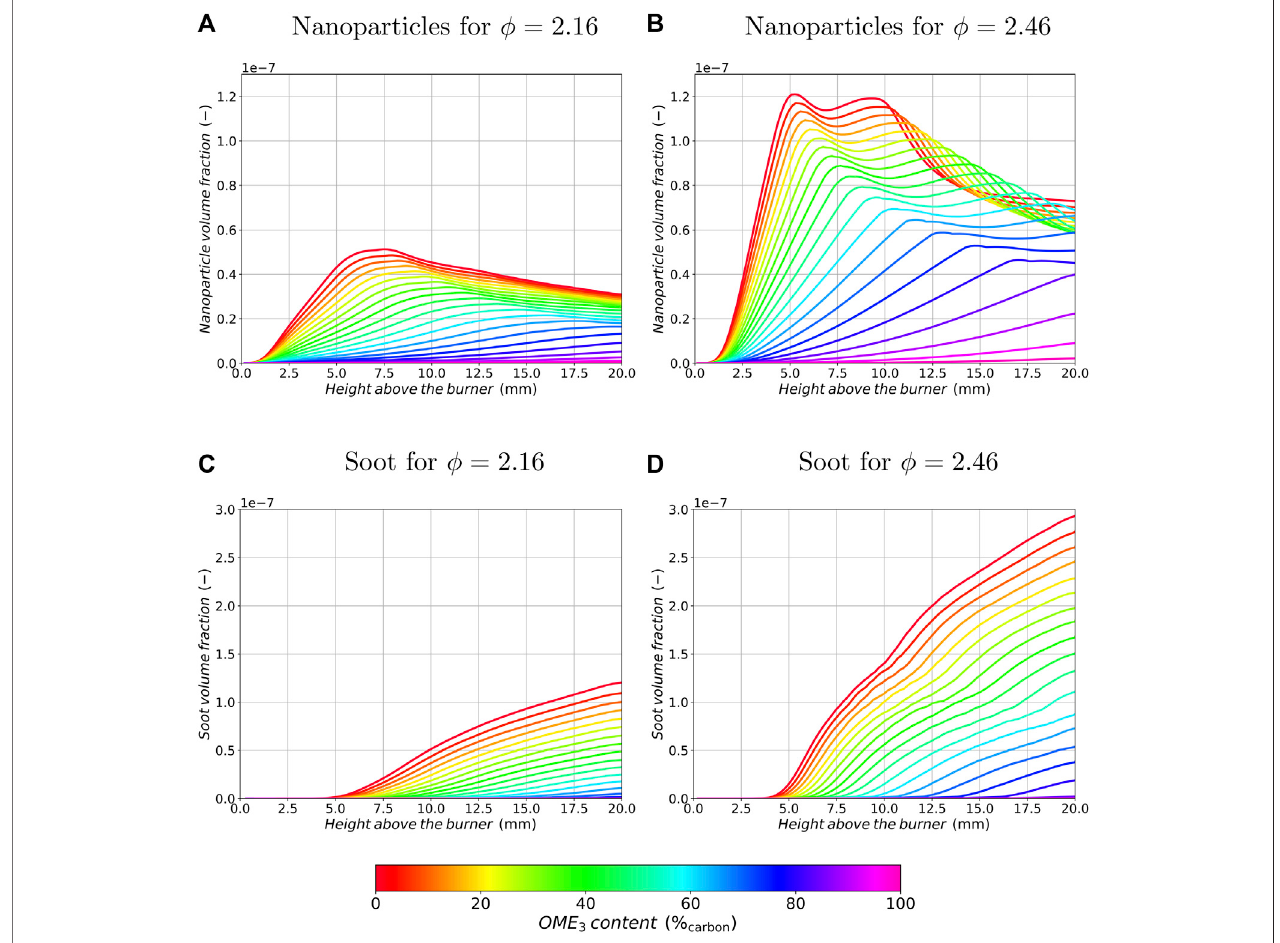
FIGURE 4 | Nanoparticle (A,B) and soot (C,D) volume fraction pro fi les as a function of the height above the burner for different OME 3 blending ratios and equivalence ratios of ϕ (cid:1) 2.16 (A,C) and ϕ (cid:1) 2.46 (B,D) .